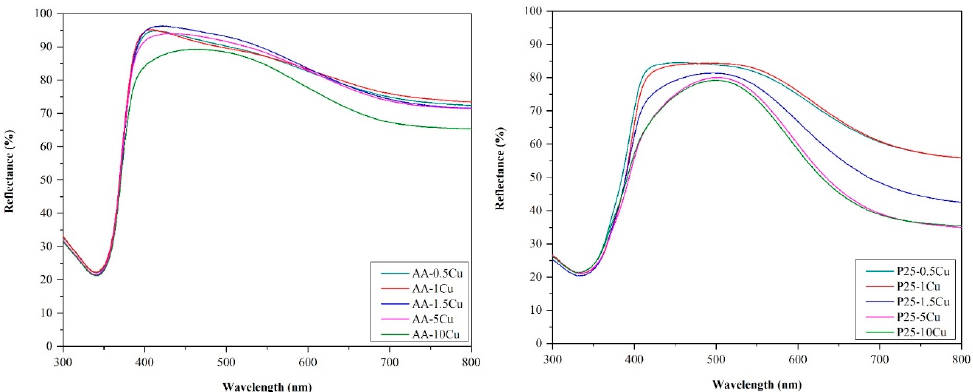
Figure 4. Diffuse reflectance spectroscopy (DRS) spectra (AA-based is shown in the top figure; P25-based is shown in the bottom figure) of the composites: The influence of the excitation threshold is more accentuated on the P25-based catalysts, while the presence of belloite shows an impact on the whole absorption spectrum and the band-gap value itself.